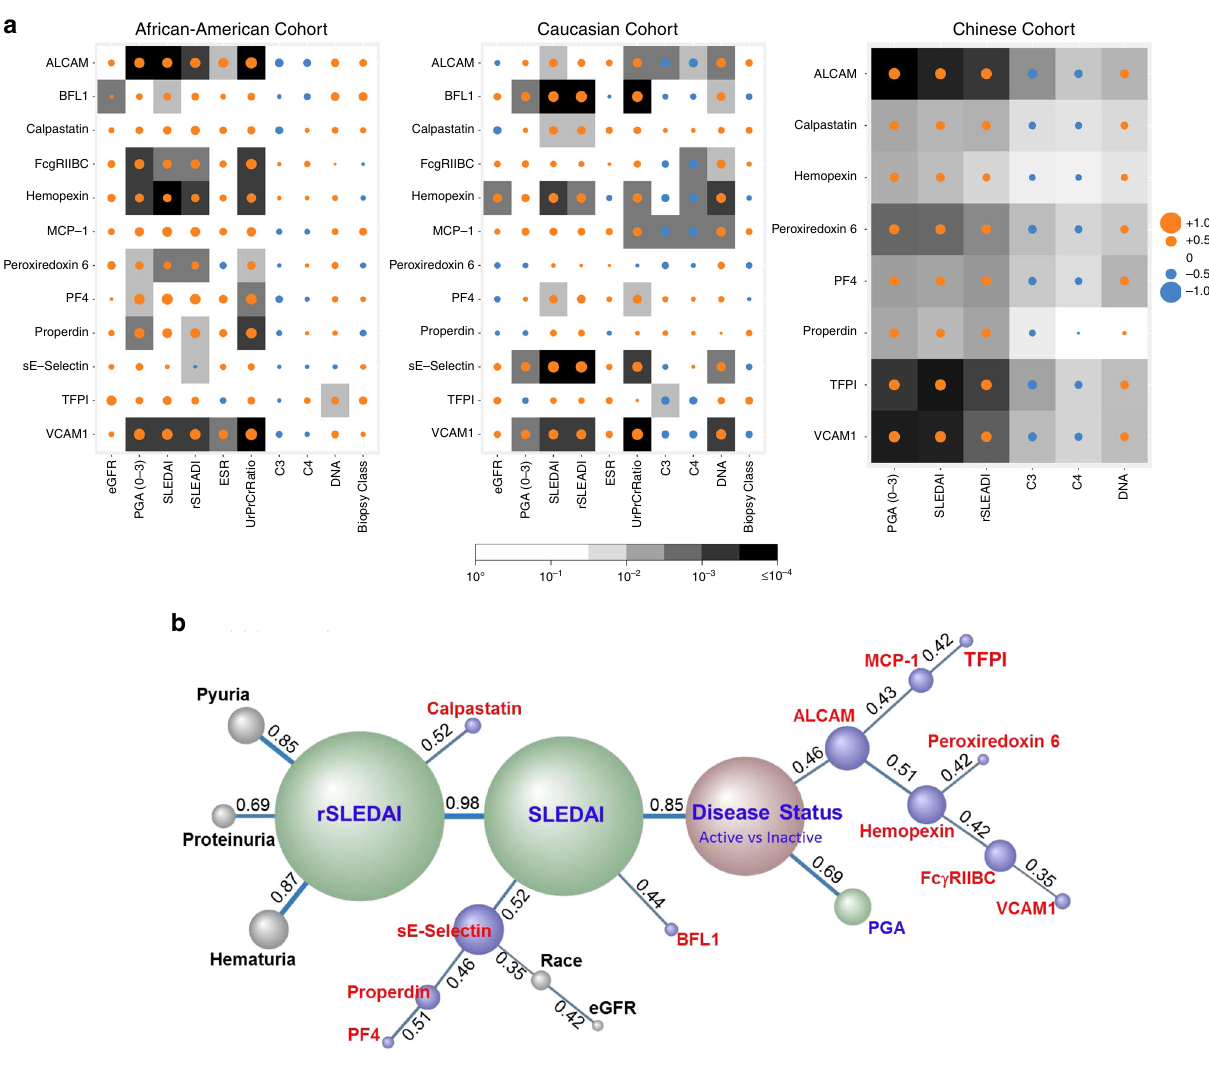
Fig. 4 Correlation and association of urine biomarkers of lupus nephritis with clinical and laboratory indices. a Creatinine-normalized urine levels of the 12 proteins (listed vertically) were Pearson correlated with various clinical and laboratory yardsticks, as listed on the x axis, in both the African-American (14 active LN, 19 inactive SLE, 14 healthy controls), Caucasian (13 active LN, 28 inactive SLE, 7 healthy controls), and Asian (80 active LN, 80 inactive SLE, 67 active non-renal lupus, 53 healthy control) patient cohorts. It should be noted that the renal biopsy data included is not from concurrent biopsies, but from previous biopsies, executed 1-mo to 20 years before urine procurement. Positive and negative correlations are denoted by orange and blue circles respectively, while statistical signi fi cance is denoted using gray-scale boxes. b The levels of the 12 urine proteins in the combined cohort (27 active LN, 47 inactive SLE, and 21 healthy controls) and their respective clinical features were subjected to Bayesian network analysis using BayesiaLab. The network shown was constructed in an unsupervised manner, using the EQ algorithm and a structural coef fi cient of 0.4. The circular nodes that make up the Bayesian Network represent the variables of interest, including urine biomarkers (purple-colored), clinical indices (green-colored), other features (colored gray) and disease status (active LN vs inactive SLE vs no disease; colored brown). The size of each node denotes the “ node force ” , which is related to its impact on other nodes in the network, based on conditional probabilities. The links (arcs) that interconnect the nodes represent informational or causal dependencies among the variables, including the correlation coef fi cients between neighboring nodes (as indicated), with the thickness of the link being proportional to the correlation coef fi